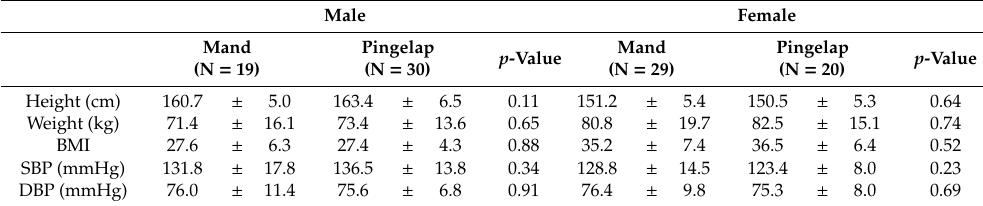
Table 3. The comparison of anthropometric measurements between two communities separately for males and females (mean ± SD).